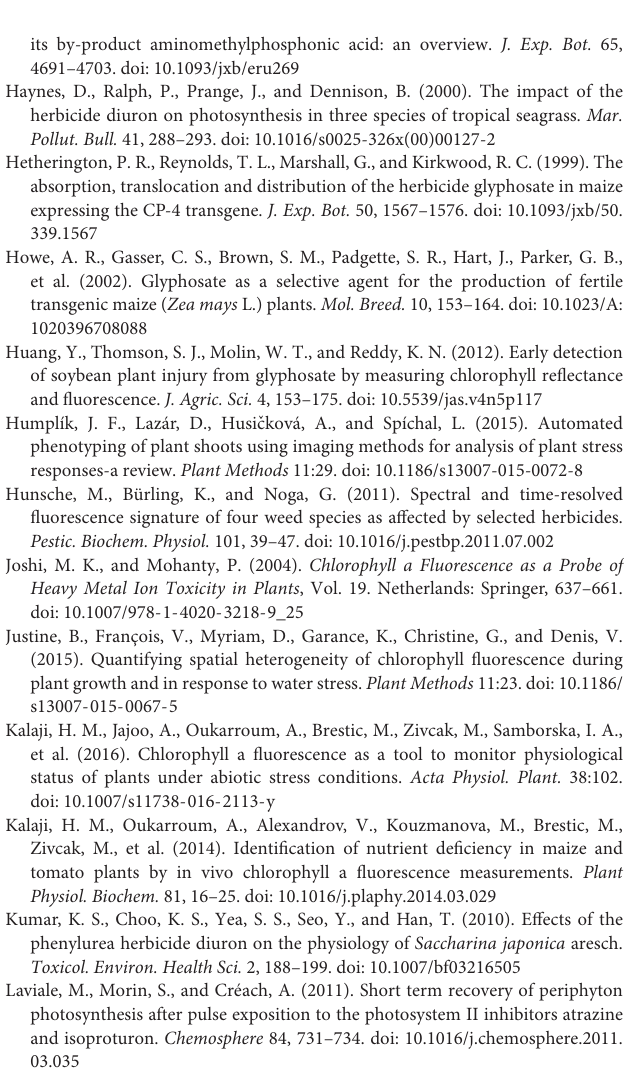
FIGURE S1 | Chlorophyll fluorescence trace illustrating the terminology and sequence of events for acquiring raw fluorescence images from plants. Dn, during dark relaxation; Ln, during light adaptation; Lss, in steady-state. FIGURE S2 | Correlation coefficients between each selected wavelengths and their spectral response to corresponding shikimic acid concentration (A) and performance of PLS-DA model established on increasing sensitive wavelengths included in the model (B) . FIGURE S3 | Results of analysis by the PLSR models for estimating shikimic acid concentration with the increasing number of sensitive ChlF parameters included in the model. TABLE S1 | Prediction results of the pre-processing models constructed by partial least-squares regression (PLSR) based on spectral information for shikimic acid